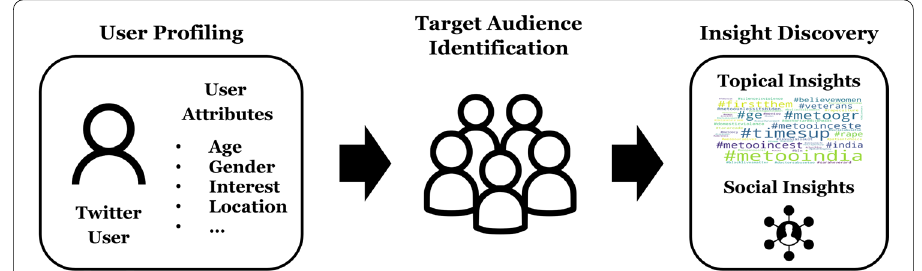
Fig. 1 The flow map of our unified scheme for developing social insights from the collective voice of target